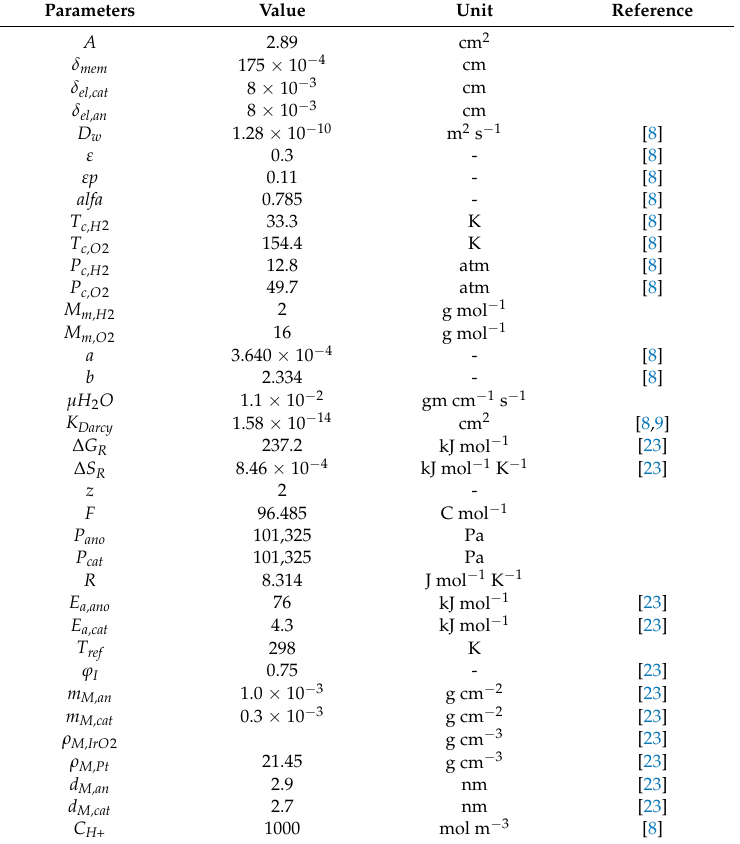
Table 3. Fixed model parameters from experimental measurements or various